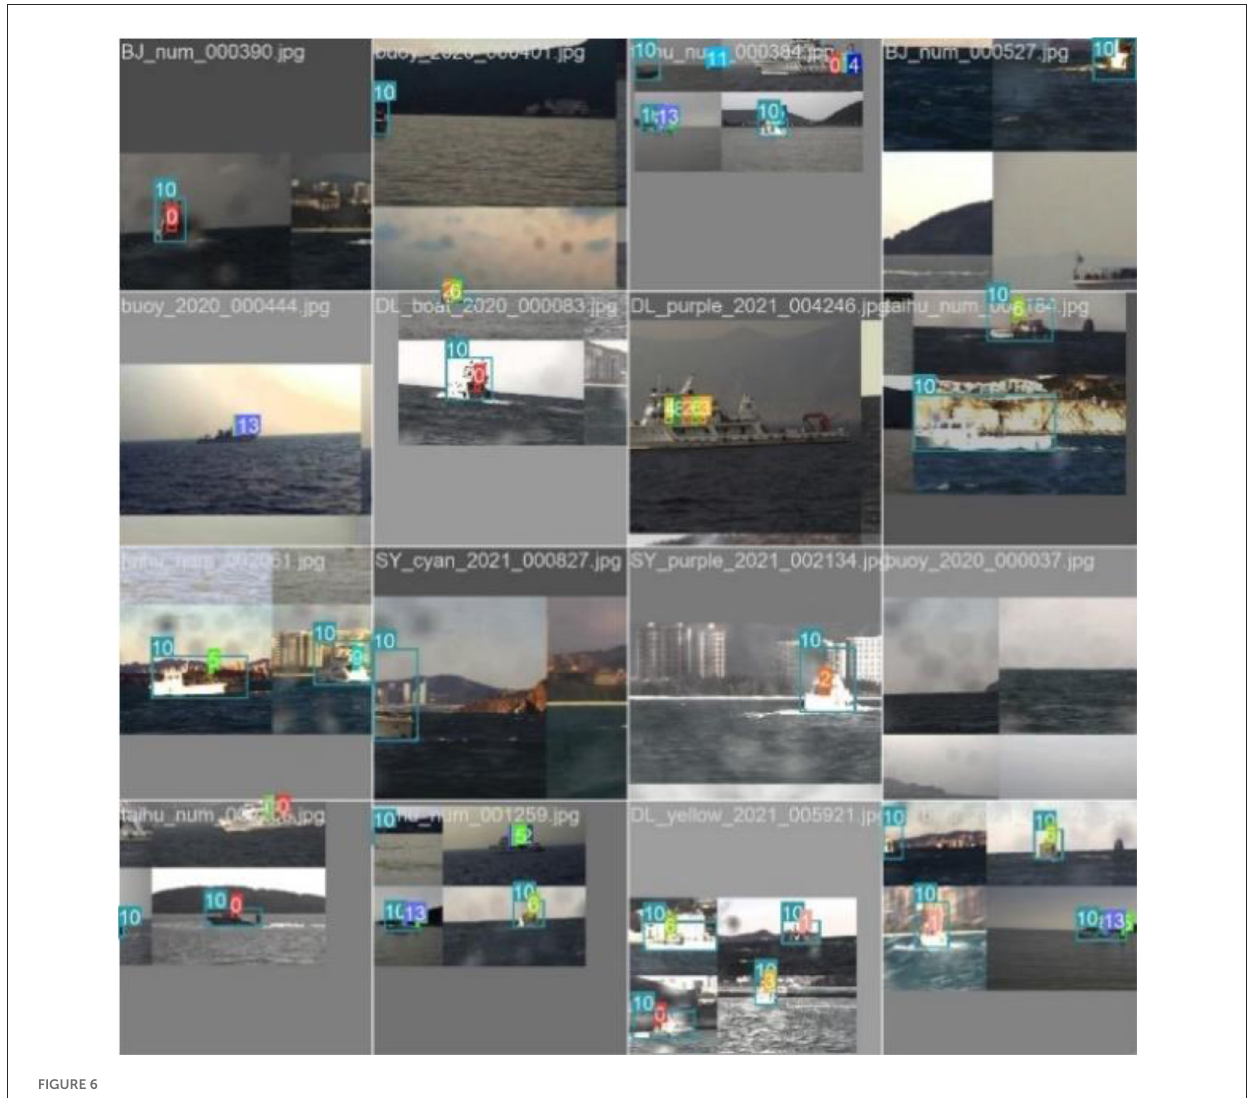
FIGURE6 The samples of dataset.